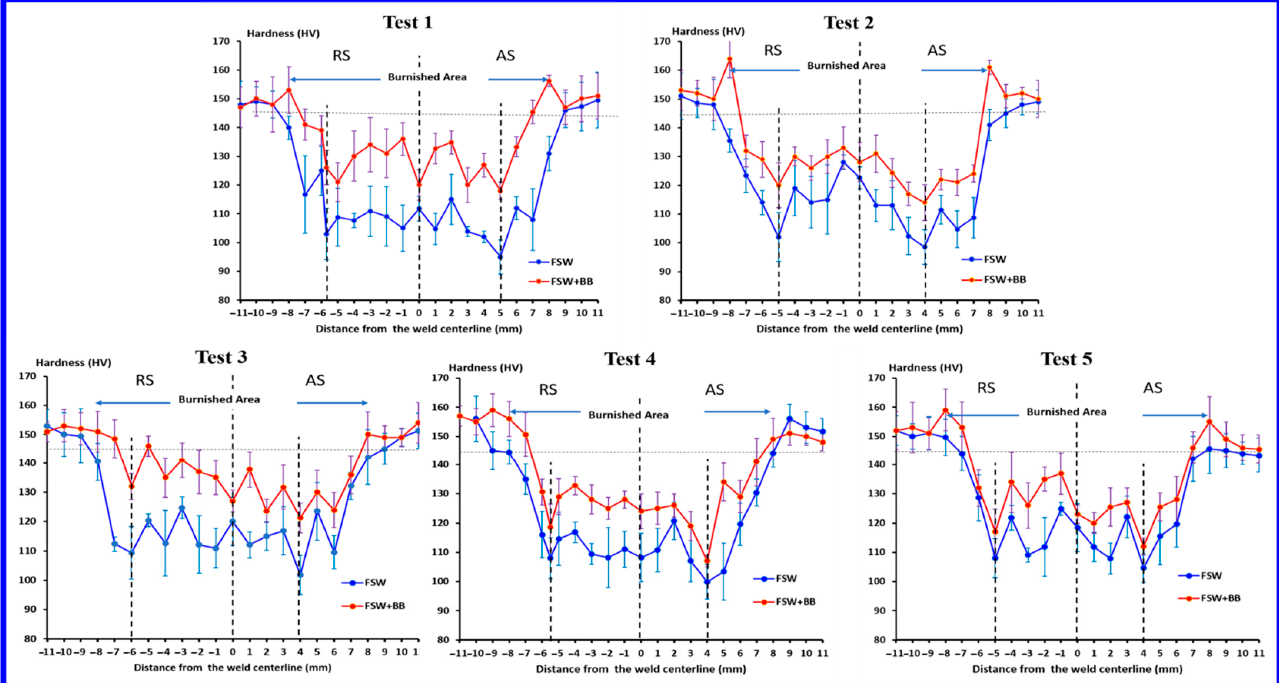
Figure 9. Comparison of microhardness evolution with/without burnishing at the surface in the welding zone along the transverse path (passing through the middle of the weld line).